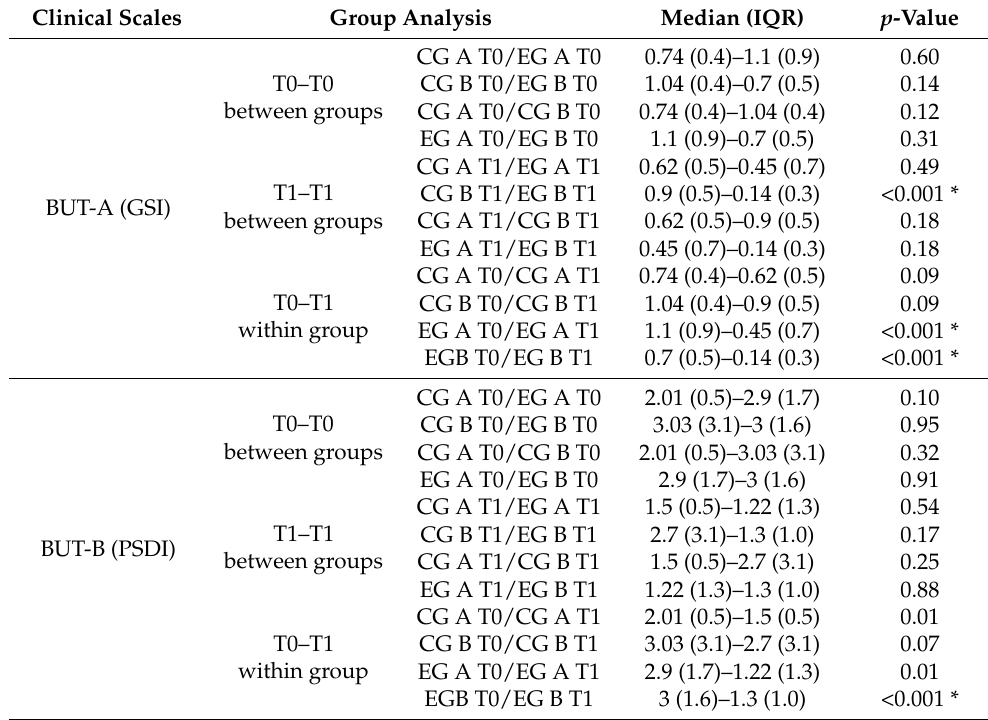
Table 2. Statistical comparison of changes in the clinical score of a primary outcome measure of patients.